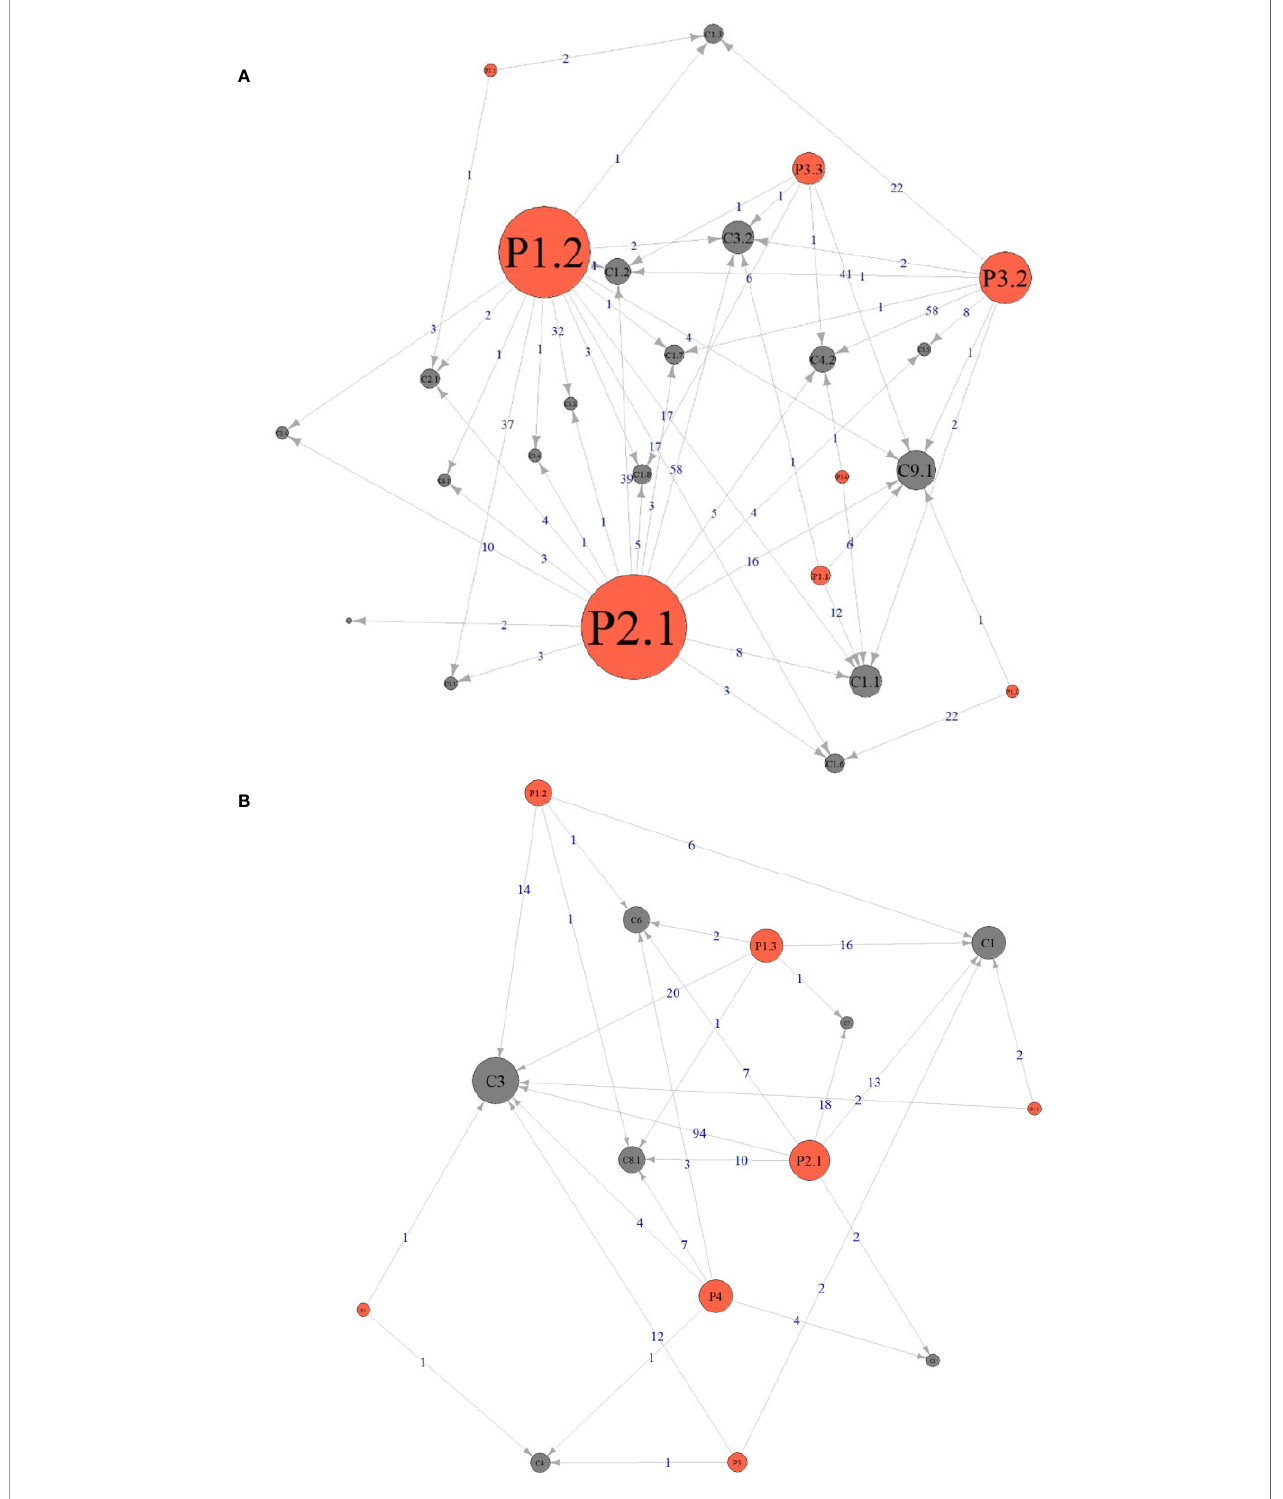
FIGURE 2 | Relationship between the drug-related problems and causes identi fi ed during pharmacy intervention (A) and consultation (B) . The size of the circle indicates how many times this DRPs or Cause was identi fi ed. An arrow pointing from P (Problems) to C (Causes) means the problem was caused by the corresponding cause and the number on the line indicates the frequency of this causal relationship. The de fi nitions of Px.x (or Px) and Cx.x (or Cx) during pharmacy intervention and consultation were listed in Tables 2 and 3 ,